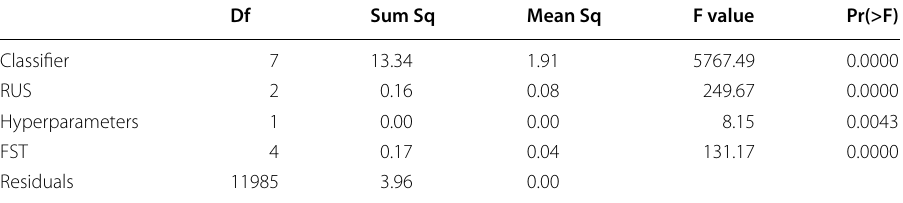
Table 8 ANOVA for classifier, RUS, hyperparameters and FST as factors of performance in terms of